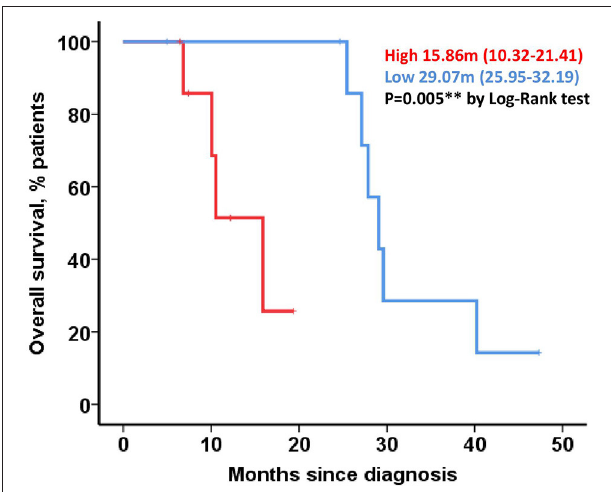
FIGURE 3 | Correlation of CHFR methylation with clinical outcomes in resectable patients. Kaplan-meier curve representing OS for resectable cohort and dichotomized by CpG-2 median methylation